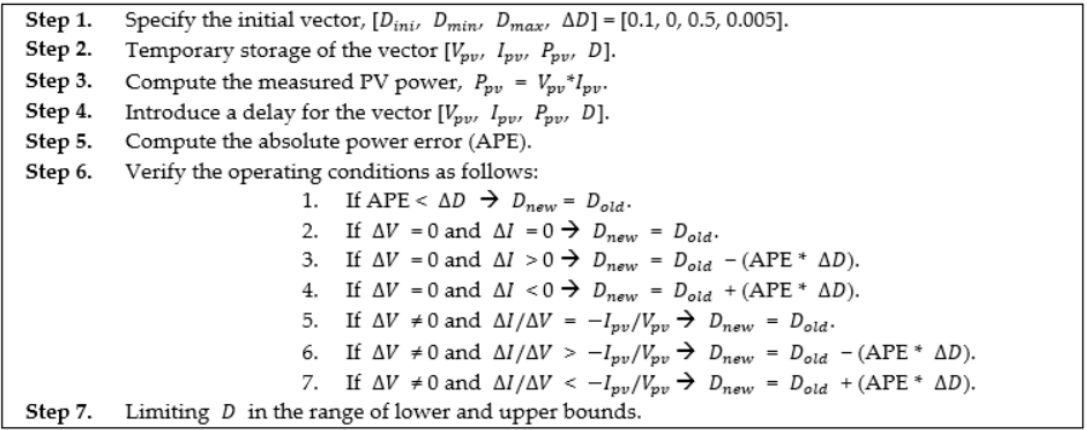
Figure 5. Pseudo code of the implemented maximum power tracking (MPPT) algorithm.